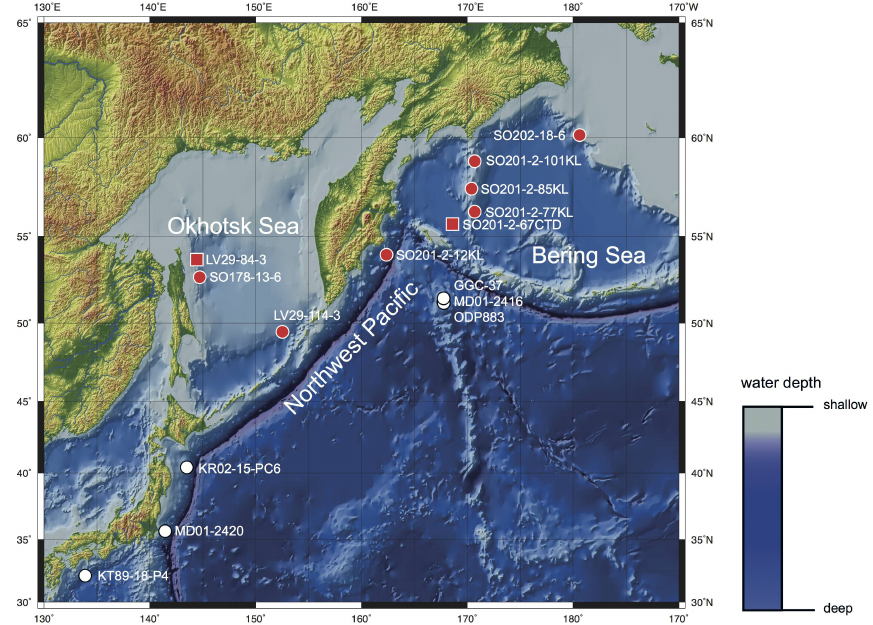
Fig. 1. Overview of the subarctic northwest Pacific and its marginal seas (Okhotsk Sea and Bering Sea). Red spots indicate core locations and red squares mark hydrocast stations obtained in this study. White spots show published sediment cores from the northwest Pacific realm considered in this study (please see Tables 2 and 3 as well as references